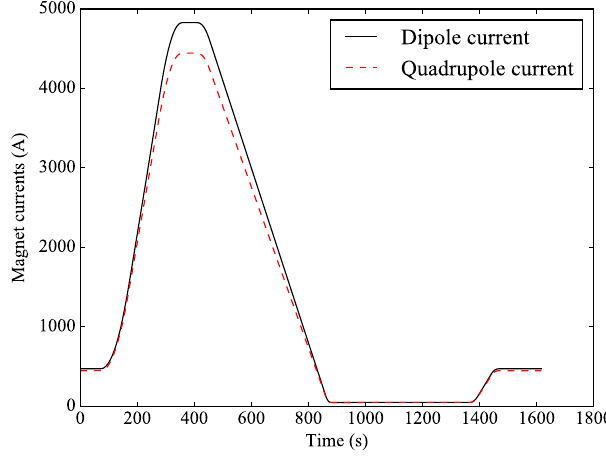
FIG. 6. Conventional magnetic cycle: RHIC superconducting dipole and quadrupole magnet currents are ramped up to currents for top energy, back down to 50 A, then up to the operating values for beam injection.